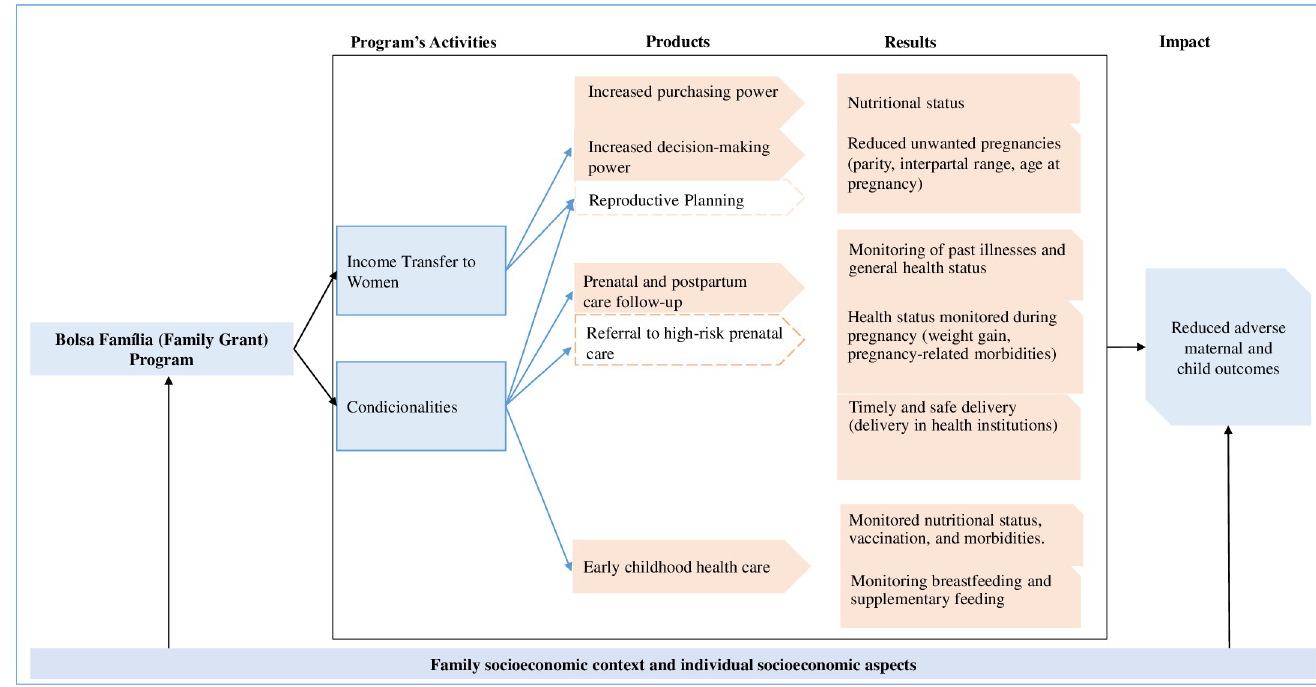
Fig 1. Logical model of the impact of the Bolsa Familia Program (BFP) in reducing adverse maternal and child outcomes.